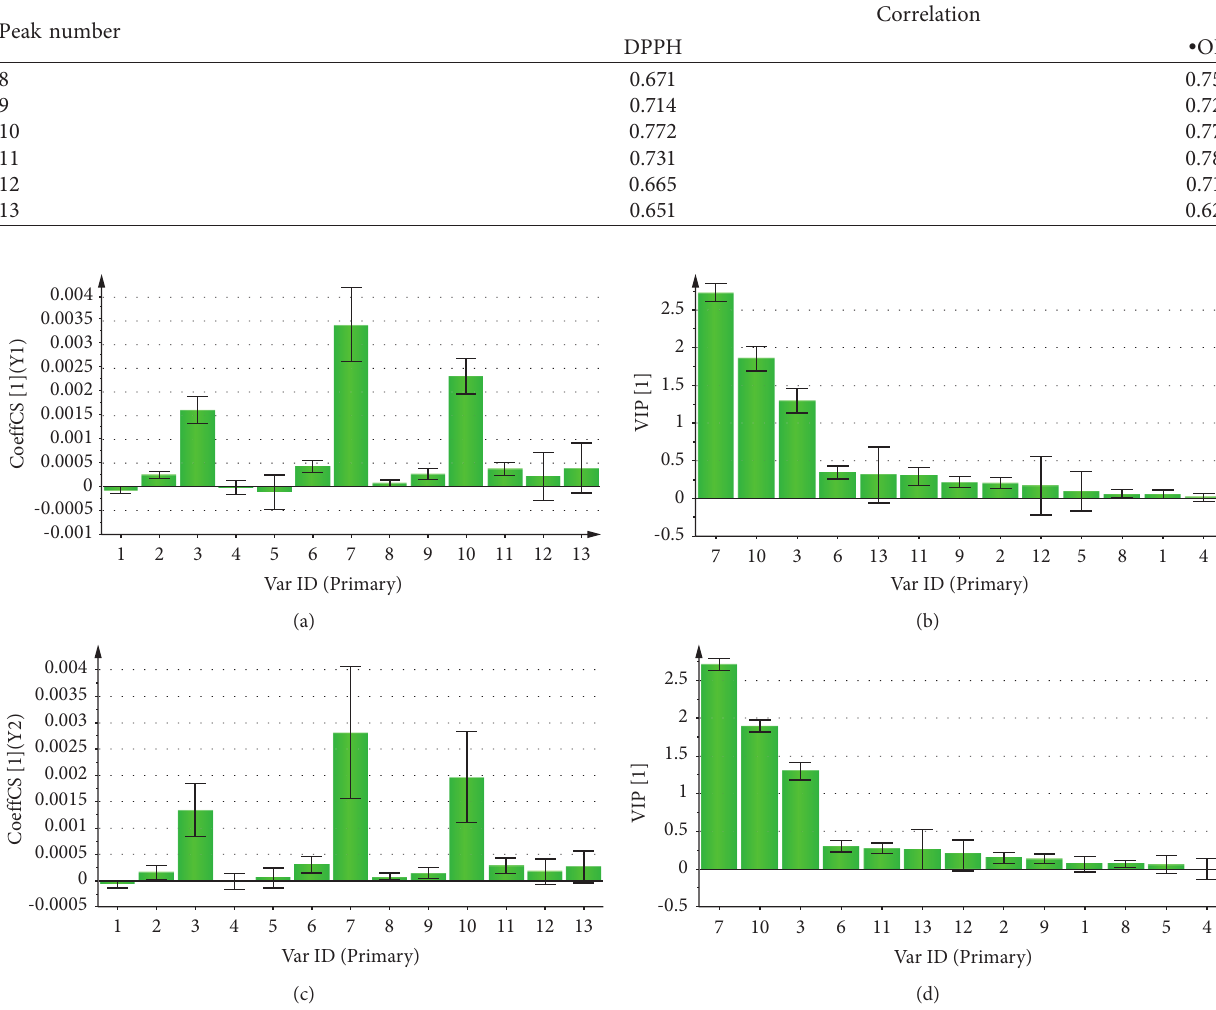
Figure 8: The coefficients of the partial least squares regression analysis of DPPH and ∙ OH radical-scavenging capacity (a, c) and the VIP values of the partial least squares regression analysis of DPPH and ∙ OH radical-scavenging capacity (b,